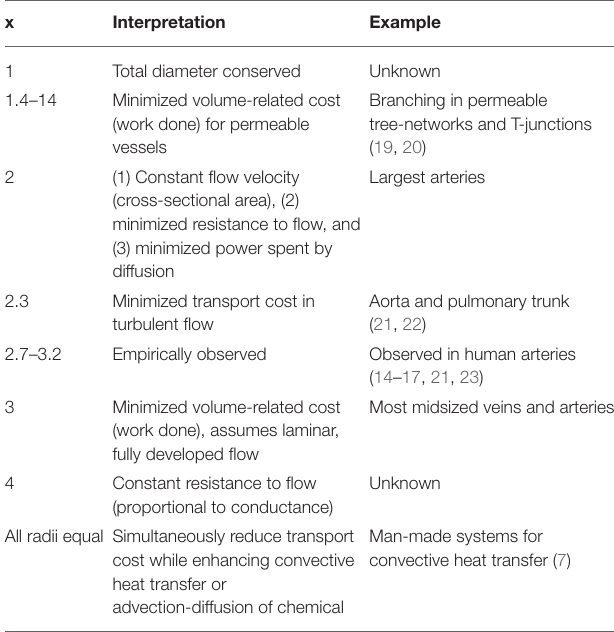
TABLE 1 | Physical interpretation of Murray’s Law